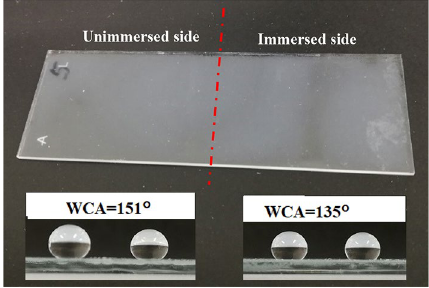
Fig. 7 Optical photographs and water repellency of the coating deposited on the glass slide by one-step spray coating of the coat- ing solution with the addition of 10 wt% PAA based on the dry weight of silica NPs (Composition No. 5) (Number of spray: 6 times) by the processing method III before and after water resistance test by immersing it into hot water at 40 °C for 68